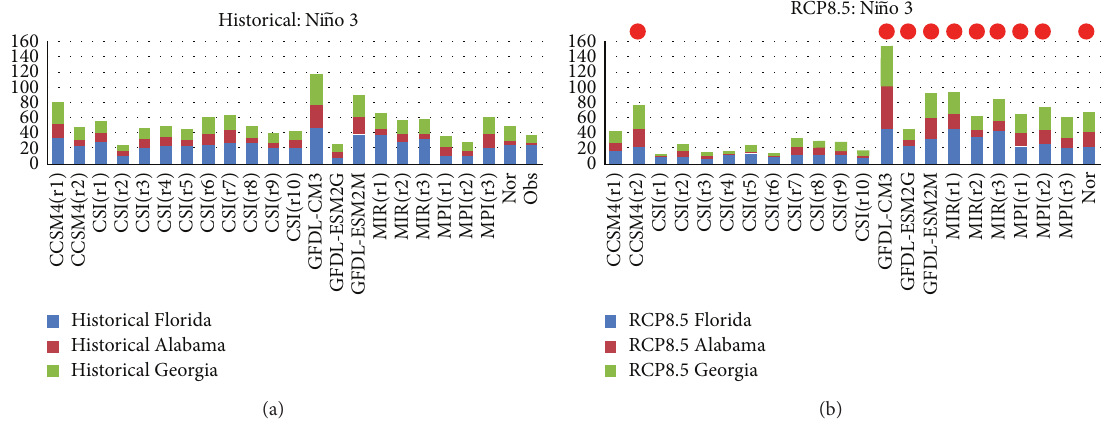
Figure3:Stackedexplainedvariances(%)forhistorical(a)andRCP8.5(b)experimentsfromCMIP5models,respectively.Explainedvariance is averaged over the States of Florida, Alabama, and Georgia, separately. All ensemble members are presented in the diagram. Observed value is included in (a) at the rightmost column.